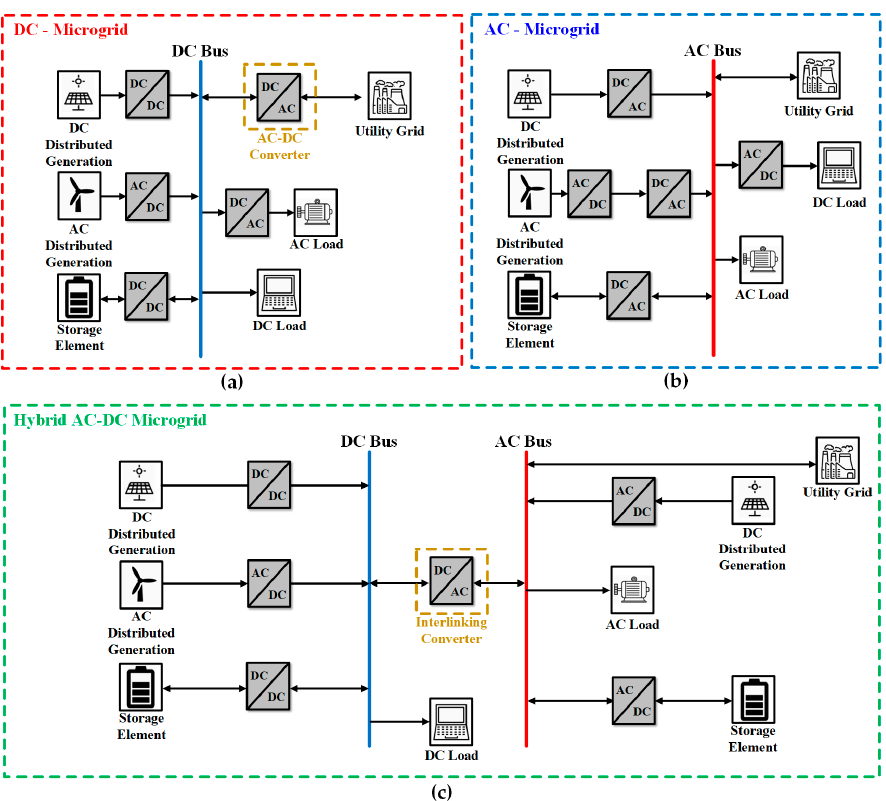
Figure 1. Classification of microgrids according to distribution network configuration ( a ) DC mi- crogrid, ( b ) AC microgrid, ( c ) hybrid AC/DC microgrid. grid, ( b ) AC microgrid, ( c ) hybrid AC/DC